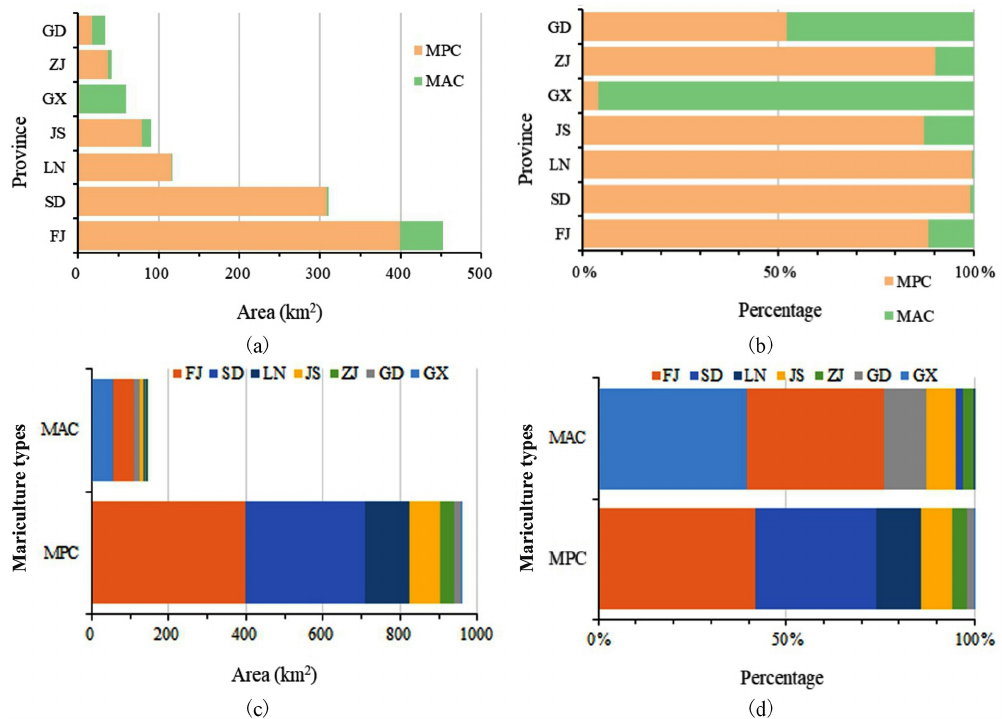
Figure 6. The amount (area) and percentage of different types of marine aquaculture distribution in the coastal provinces of China. LN, SD, JS, ZJ, FJ, GX, and GD indicate Liaoning, Shandong, Jiangsu, Zhejiang, Fujian, Guangxi, and Guangdong provinces,